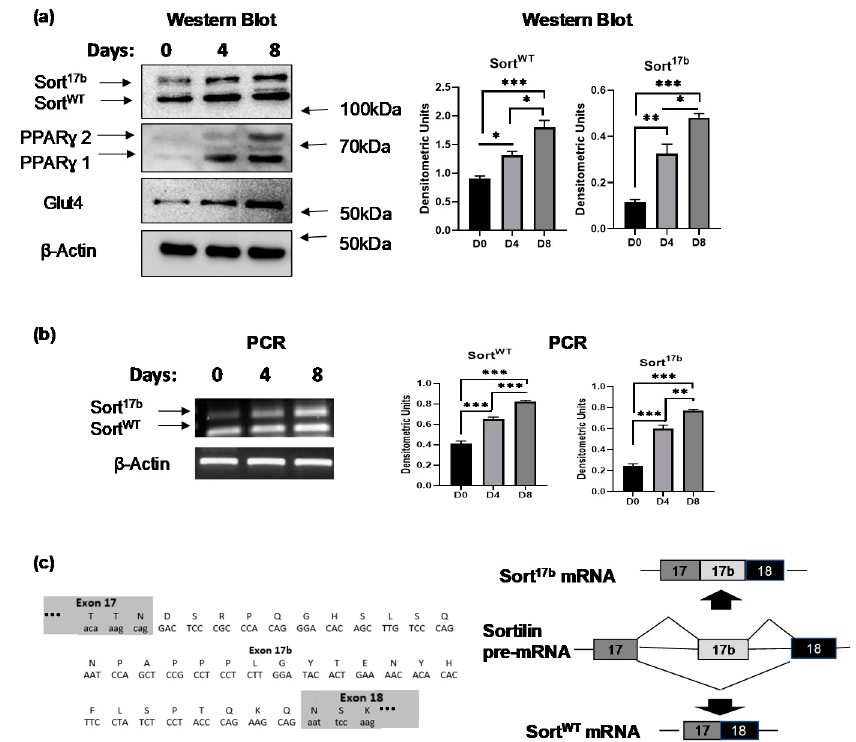
Figure 1. Sortilin alternatively spliced variants’ expression during adipogenesis. 3T3L1 preadipocytes were differentiated and harvested at days 0 (pre-adipocytes), day 4 (terminally differentiated adipocytes), and day 8 (mature adipocytes). ( a ) Western blot analysis was performed on lysates harvested on days 0, 4 and 8 and probed using antibodies against sortilin, peroxisome proliferator activated receptor G (PPAR γ ), glucose transporter-4 (Glut4) or β -actin as indicated in the figure. Graphs show densitometric analysis of individual bands for each protein that are normalized to β -actin ( n = 5). Statistical analysis was performed by one-way ANOVA; * p < 0.05, ** p < 0.01, and *** p < 0.001 between day 0 and day 4 samples or day 0 and day 8 samples. ( b ) RNA was isolated on days 0, 4 and 8, followed by PCR analysis using primers specific to sortilin exon 17 (sense) to exon 19 (anti-sense). The PCR products were separated on a 1% agarose gel and visualized using ethidium bromide staining. Graphs show densitometric analysis of individual PCR products normalized to β -actin ( n = 5). Statistical analysis was performed by one-way ANOVA; ** p < 0.01, and *** p < 0.001 between days 0, 4, and 8 samples for wildtype (Sort WT ) and sortilin variant with included exon 17b (Sort 17b ) variants. ( c ) The two PCR products obtained using primers to sortilin exon 17 (sense) to exon 19 (anti-sense) were purified and sequenced. Sequencing results revealed inclusion of a 99 bp sequence, named exon 17b, between exons 17 and 18 of sortilin mRNA. The schematic depicts sortilin pre-mRNA alternative splicing generating Sort WT mRNA (exclusion of exon 17b) and Sort 17b mRNA (inclusion of exon